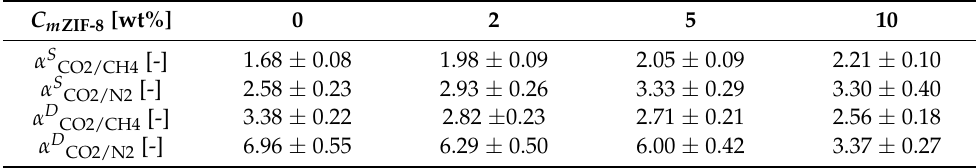
Table A6. Coefficients α S i/j and α D i/j for membranes of different ZIF-8